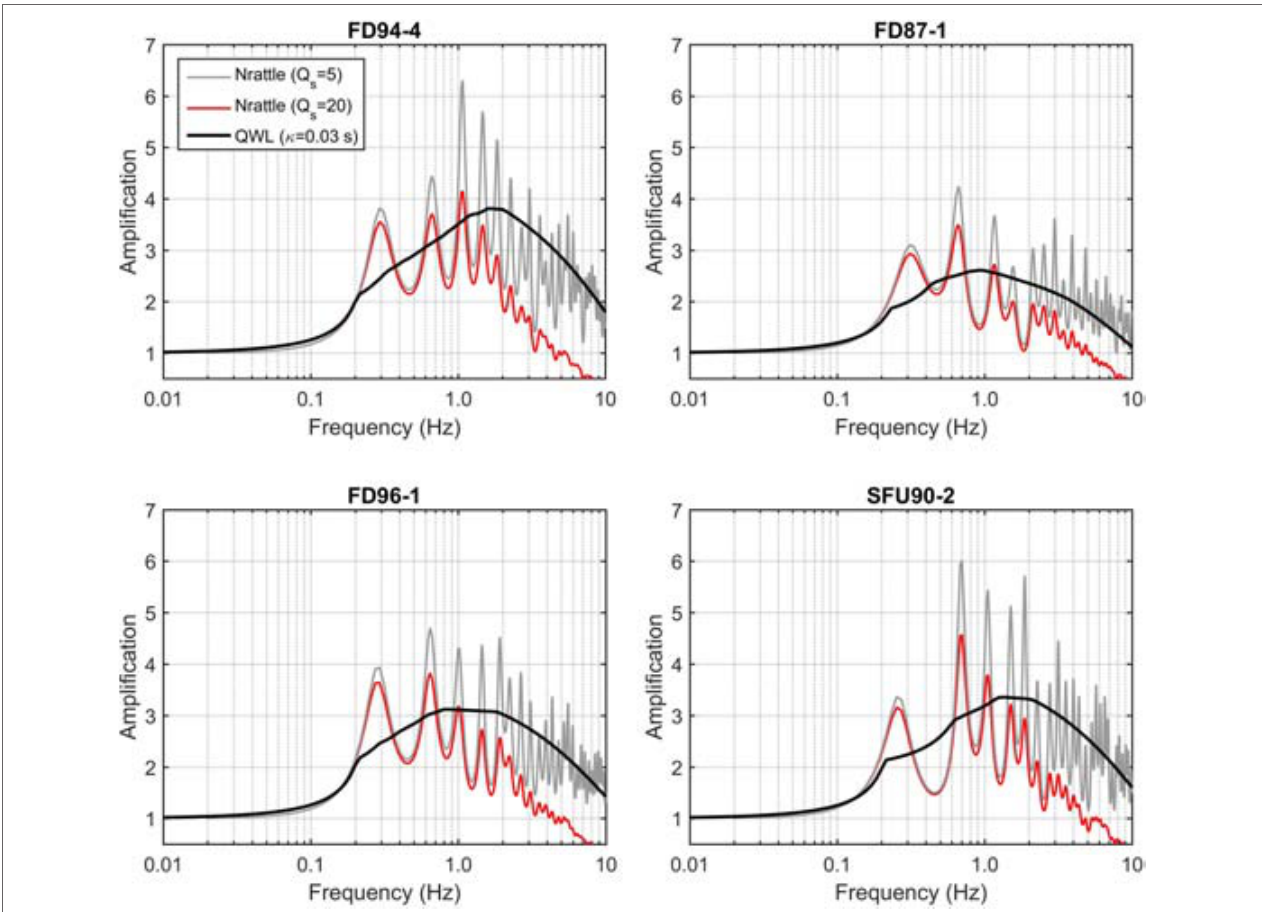
FIGURE 11 | Transfer (i.e., linear amplification) functions of four select Fraser River Delta sites. The gray and red curves are the theoretical site response computed using Nrattle with Q S = 5 and Q S = 20, respectively. The black curve is the amplification factor based on the quarter-wavelength method using kappa of 0.03s.